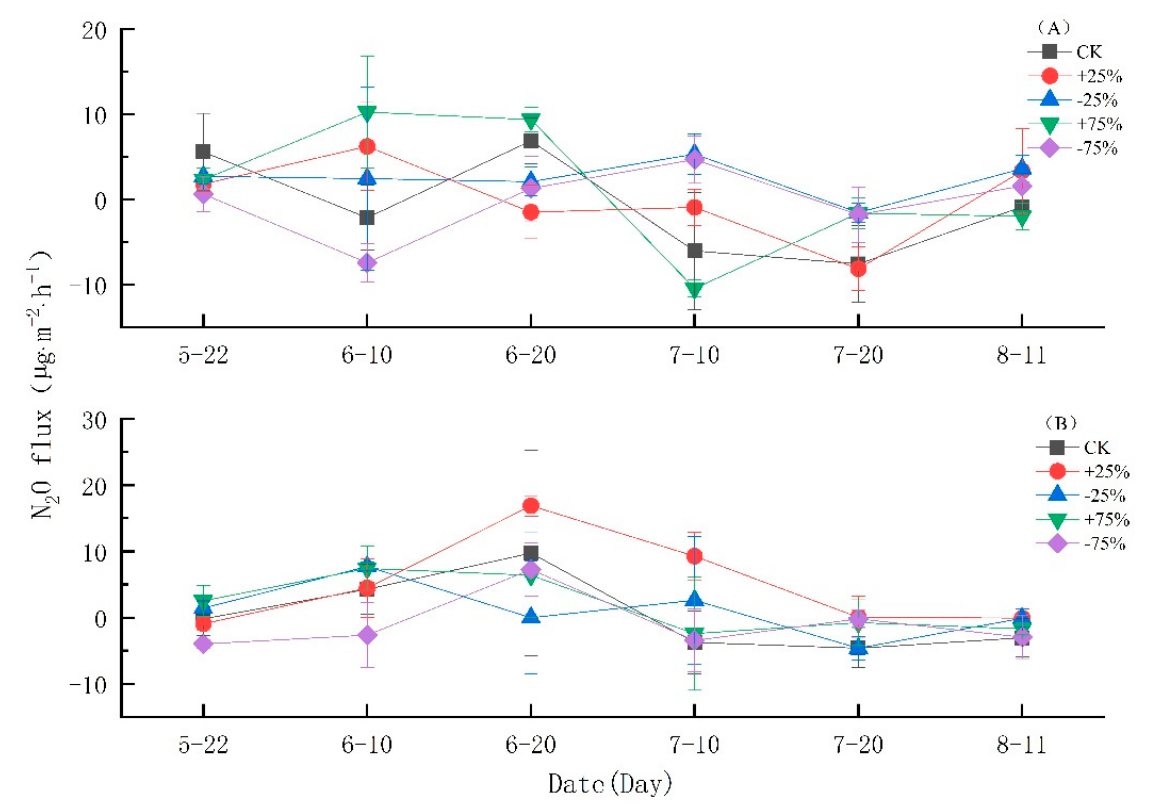
Figure 4. N 2 O emission characteristics during the growing season under different rainfall treatments. Change diagram of the N 2 O emission flux at 11:00 a.m. ( A ). Change diagram of the N 2 O emission flux at 3:00 p.m. ( B ). Table 1. Multiple comparisons of the CO 2 , CH 4 , and N 2 O fluxes treated by five types of rainfall in the Niaodao Lakeside wetland.